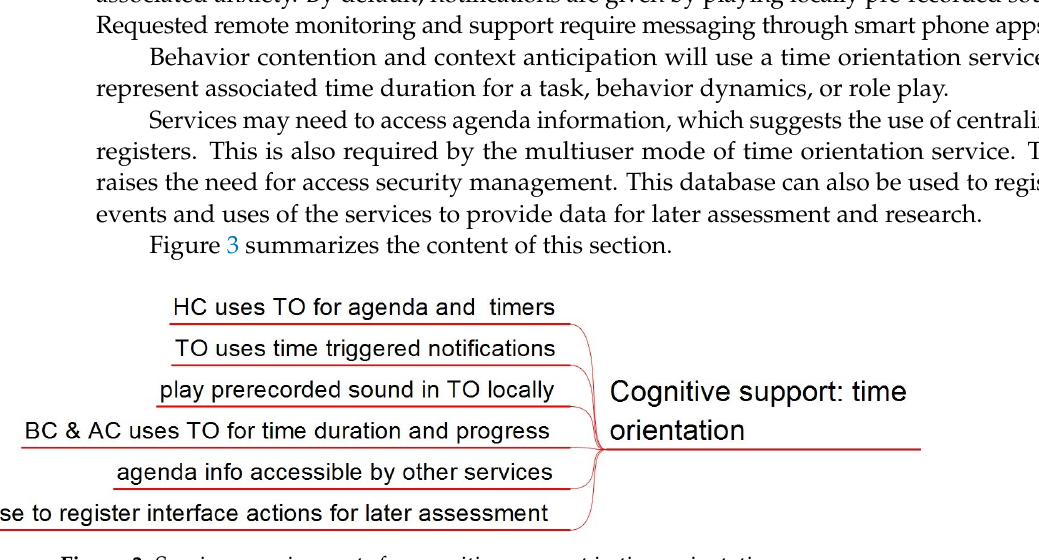
Figure 4. Services requirements for cognitive support in self-awareness. 3.2.5. Services Requirements for Social Interaction Support As an educational tool, all services require multiuser mode to support group activi- ties in the class. Frequently, children’s cognitive capacities will be very different from each other, so this leads to the requirement of individualized interfaces operating over the same centralized system or database. A quick enough refresh of the interfaces correlated to the database is needed, for the status of each element in home control to provide for real time perception. Figure 5 summarizes the content of this section.